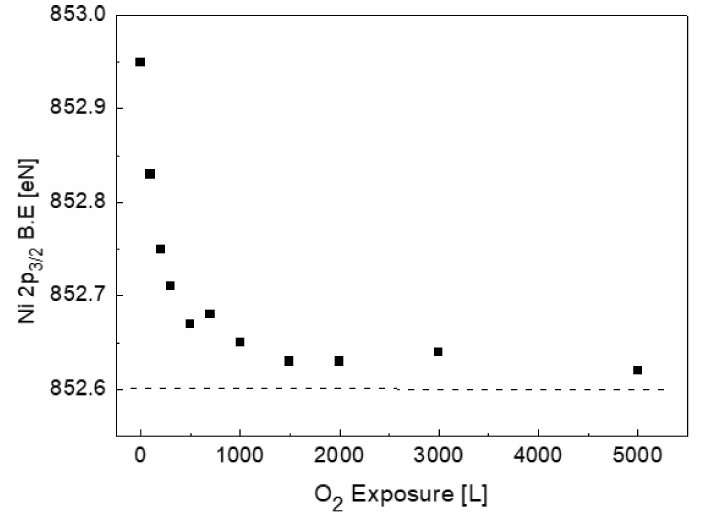
Figure 6. The change in the BE of Ni 2p 3/2 vs. oxygen exposure. The BE decreases during oxygen exposure, approaching the value of pure Ni (the horizontal dashed